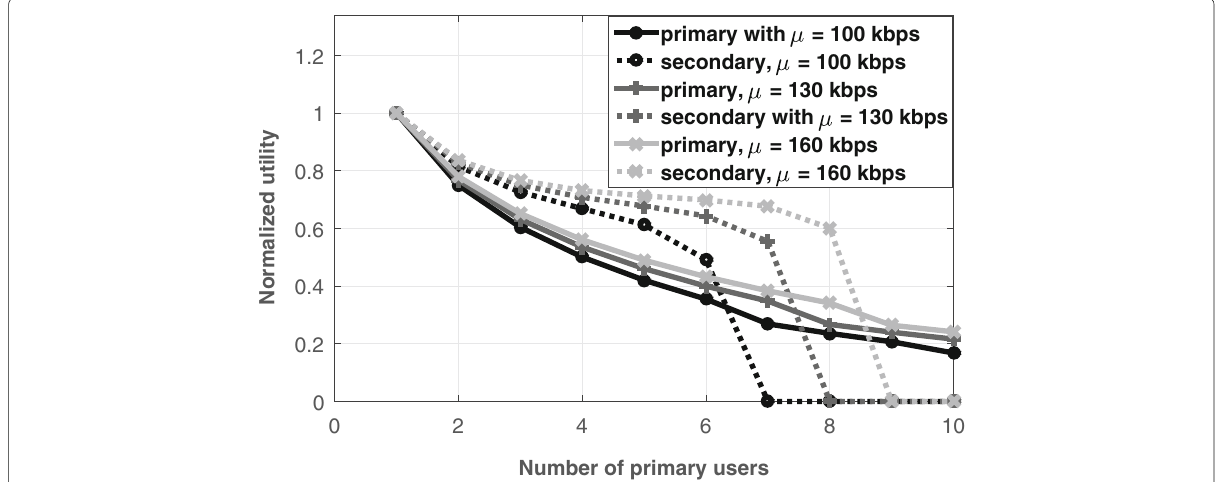
Fig. 6 The two players’ normalized utilities versus the number of primary users with n s = 3, λ p = 10 kbps, λ s = 1 kbps, and different μ ranging from 100 to 160 kbps for the Stackelberg games in Section 3.2 and cost function defined with Eq.